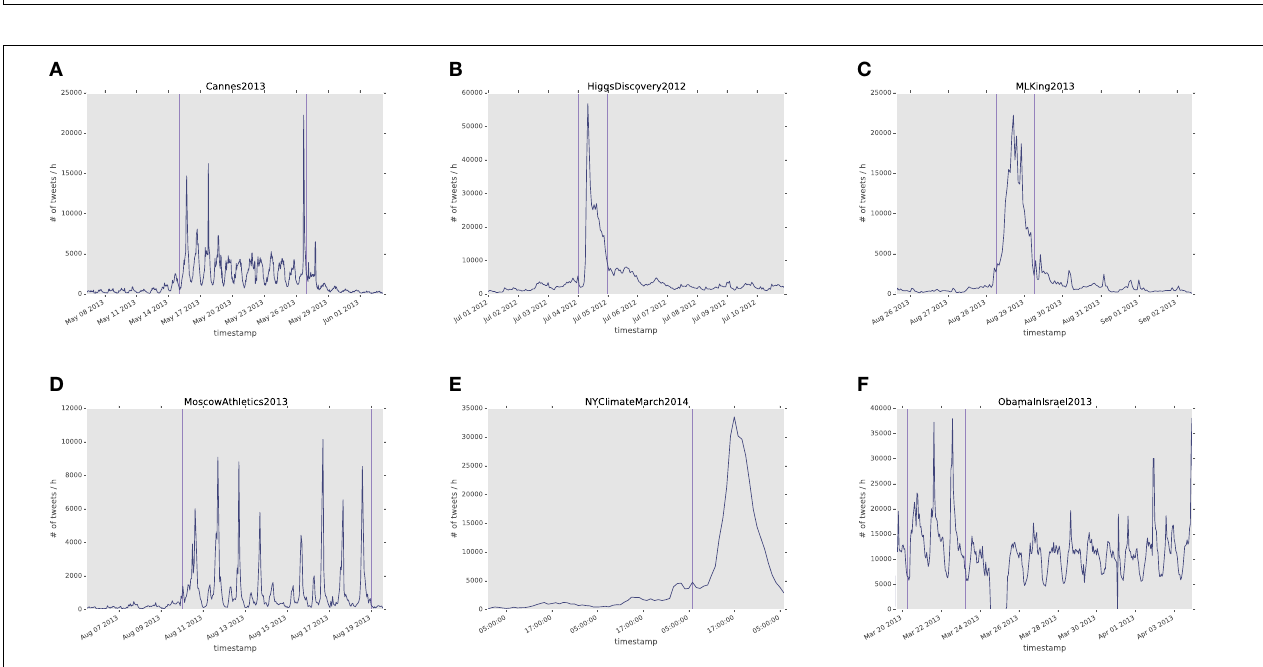
FIGURE 2 | Volume of tweets, in units of number of messages posted per hour, over time for the six exceptional events considered in our study. In panels (A–F) we show the volume corresponding to each exceptional event reported in Table 1 , respectively.